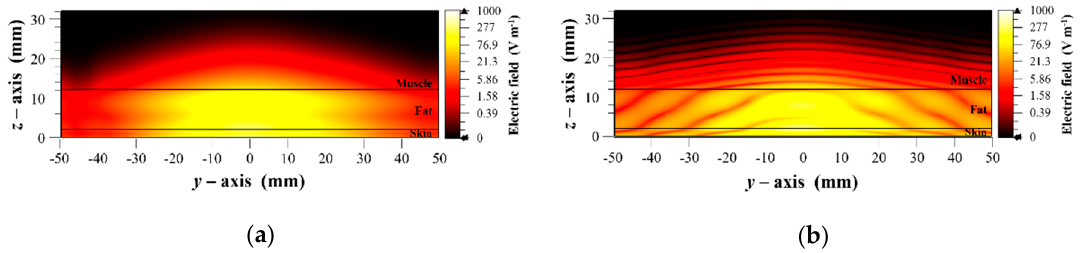
Figure 8. Simulated electric field 2D distribution in the yz plane at the frequency f = 11 GHz; ( a ) SIW cavity-backed patch antenna with SRR superstrate placed at distance D = 10 mm from the human tissue; ( b ) SIW cavity-backed patch antenna placed at distance D = 10 mm from the human tissue without SRR superstrate.